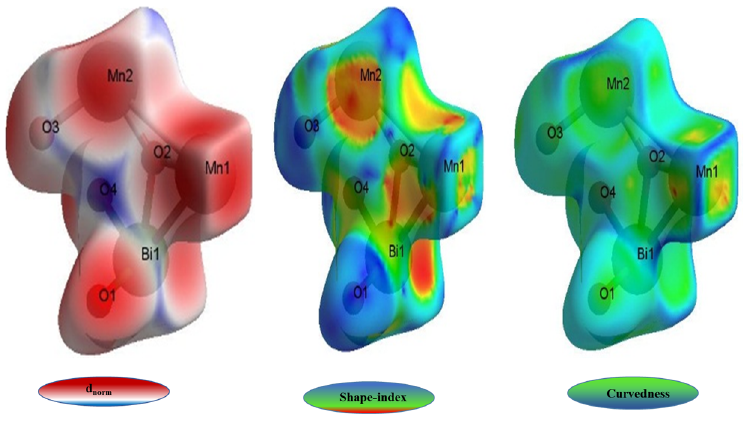
Figure 2. Hirshfeld surface analysis of BiMn 2 O 5 d norm , shape-index, and curvedness.